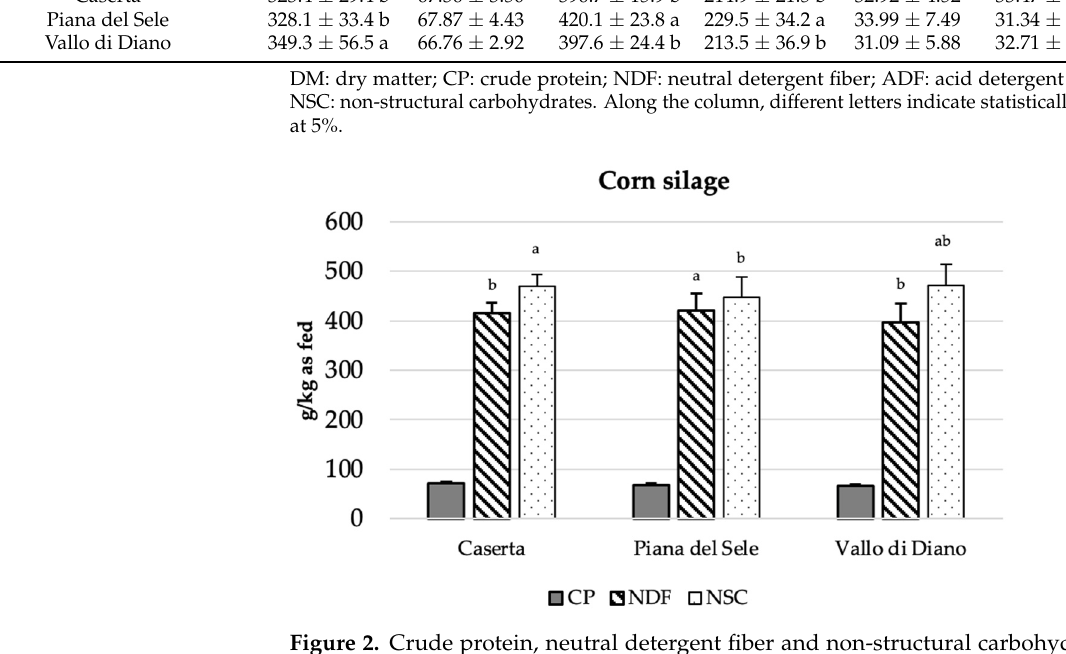
Figure 2. Crude protein, neutral detergent fiber and non-structural carbohydrates of silages. CP: crude protein; NDF: neutral detergent fiber; NSC: non-structural carbohydrates. Different letters indicate statistically significant differences at 5%.